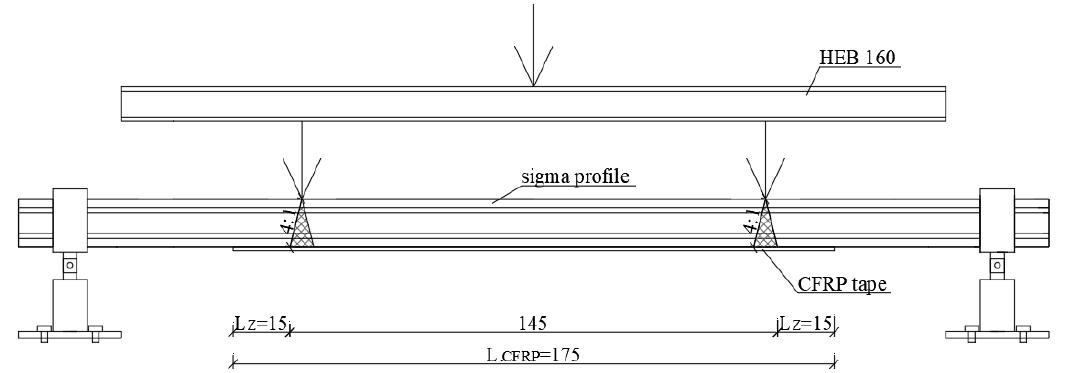
Figure 1. Scheme defining the determination of the carbon fibre reinforced polymer (CFRP) effective anchorage length. Materials 2020 , 13 , x FOR PEER REVIEW